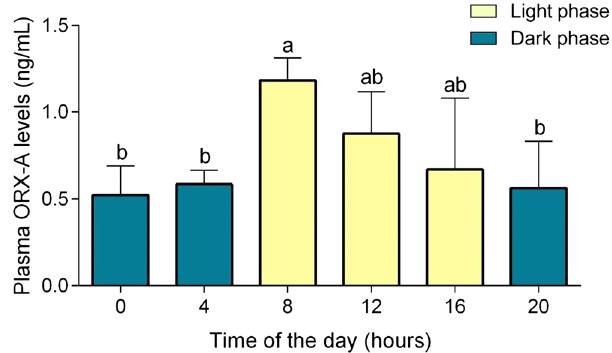
Figure 2. ORX-A plasma levels throughout the day. Variation during 24 h of the plasma levels of ORX-A in the green iguana (values represented as means ± s.e.m.). The yellow bars represent the light phase, while the blue bars represent the dark phase. Different letters mean significant statistical difference, and same letters mean that the difference is not statistically significant. Number of animals: 4 for each time of the day (total: